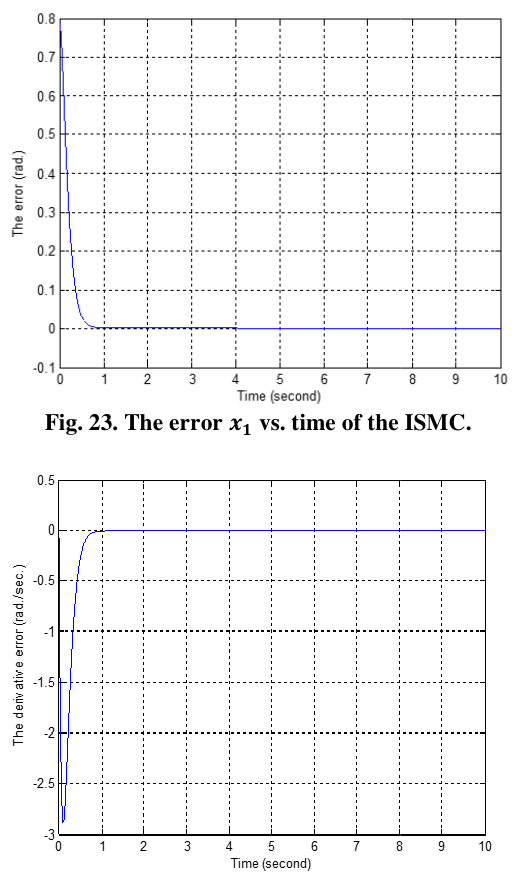
Fig. 27. The plot of phase plane between the error The plot of phase plane between the error vs. time b of the ISMC. _ ‘ and the derivative error _ b of the ISMC.